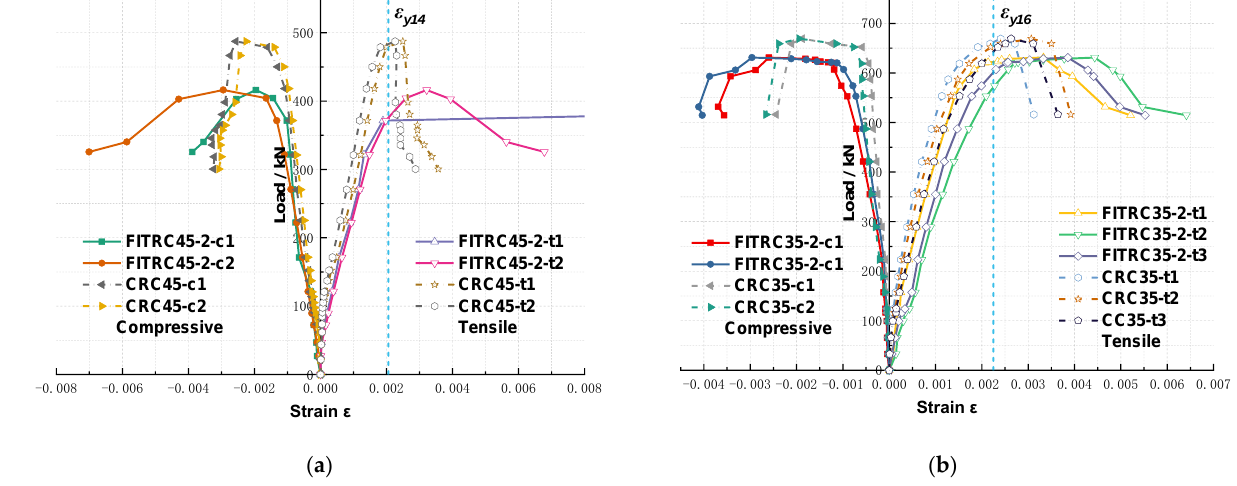
Figure 13. Load–rebar strain curves of typical RC columns: ( a ) e 0 / h 0 = 0.60; ( b ) e 0 / h 0 = 0.70. Concrete strain gauges were placed along the section depth of the RC column, as